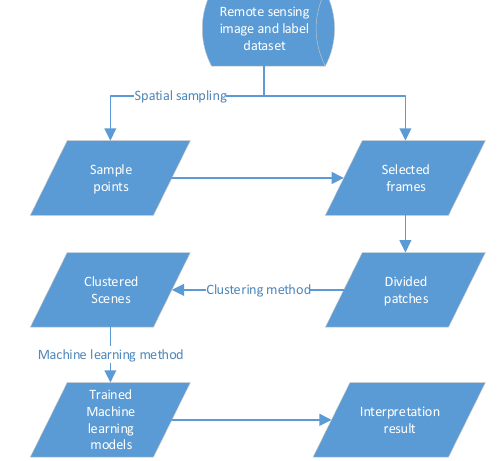
Figure 1. Main flow for building the sample